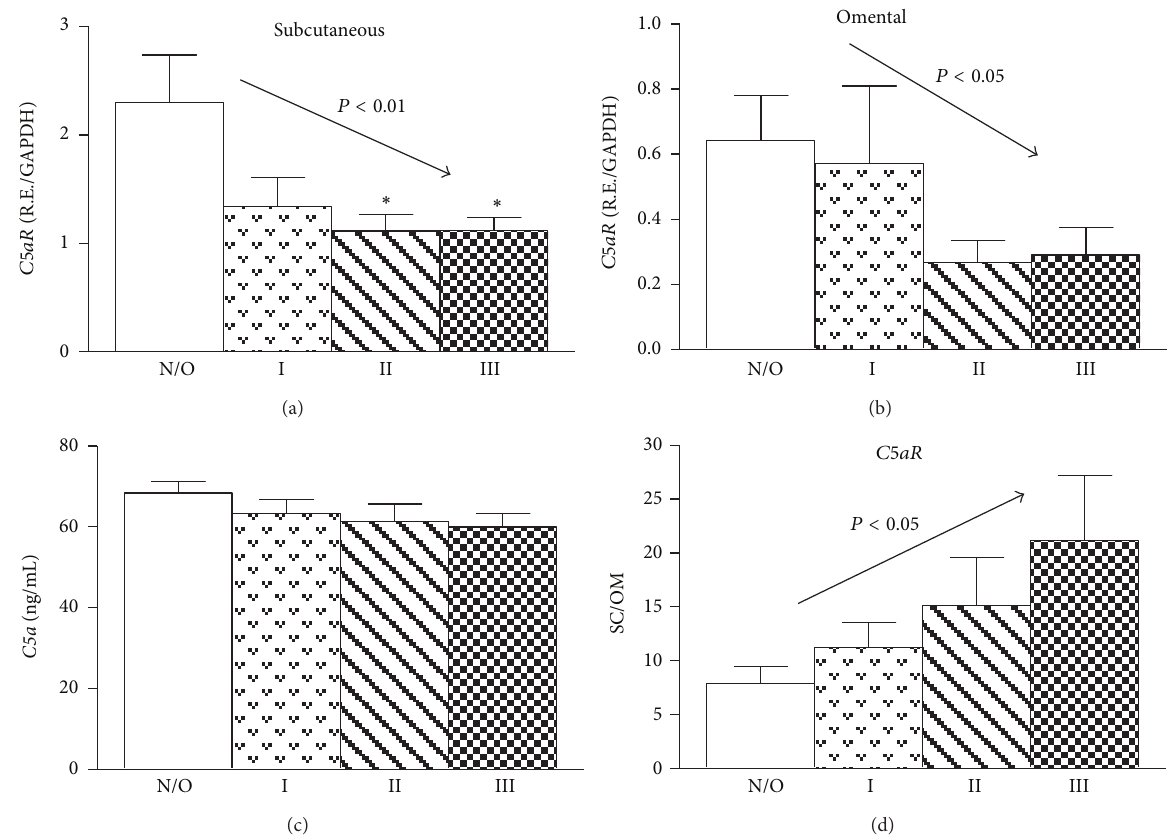
Figure 2: C5aR expression in both subcutaneous and omental adipose tissues is downregulated in obesity. Subcutaneous (a) and omental (b) C5aR mRNA expression for normal/overweight (open bar), obese group I (dotted bar), obese group II (striped bar), and obese group III (checkered bars), (c) plasma C5a for normal/overweight (open bar), obese group I (dotted bar), obese group II (striped bar), and obese group III (checkered bars), and (d) subcutaneous/omental C5aR expression for normal/overweight (open bar), obese group I (dotted bar), obese group II (striped bar), and obese group III (checkered bars). Results are expressed as means ± SEM; 𝑛 = 33–36 per group. Statistical differences were determined by Student’s 𝑡 -test and one-way ANOVA, for normal/overweight versus obese groups, where ∗ 𝑃 < 0.05